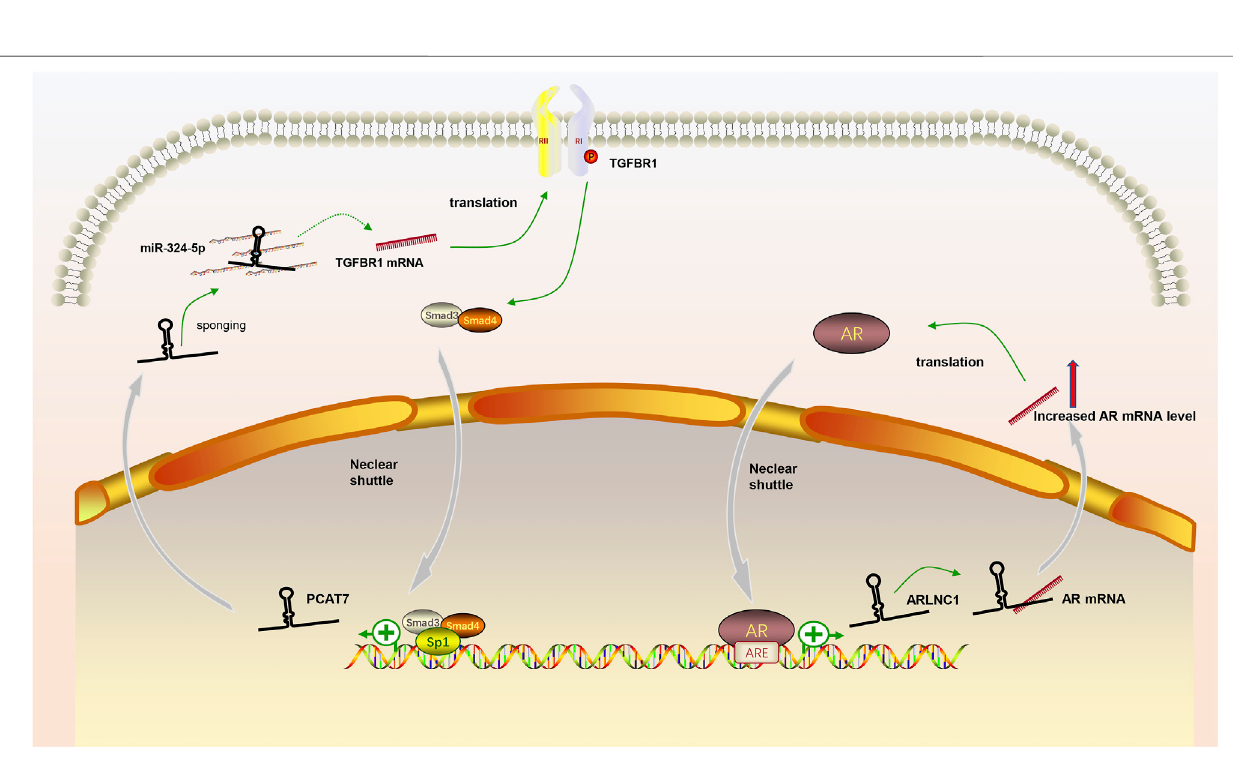
Frontiers in Molecular Biosciences |